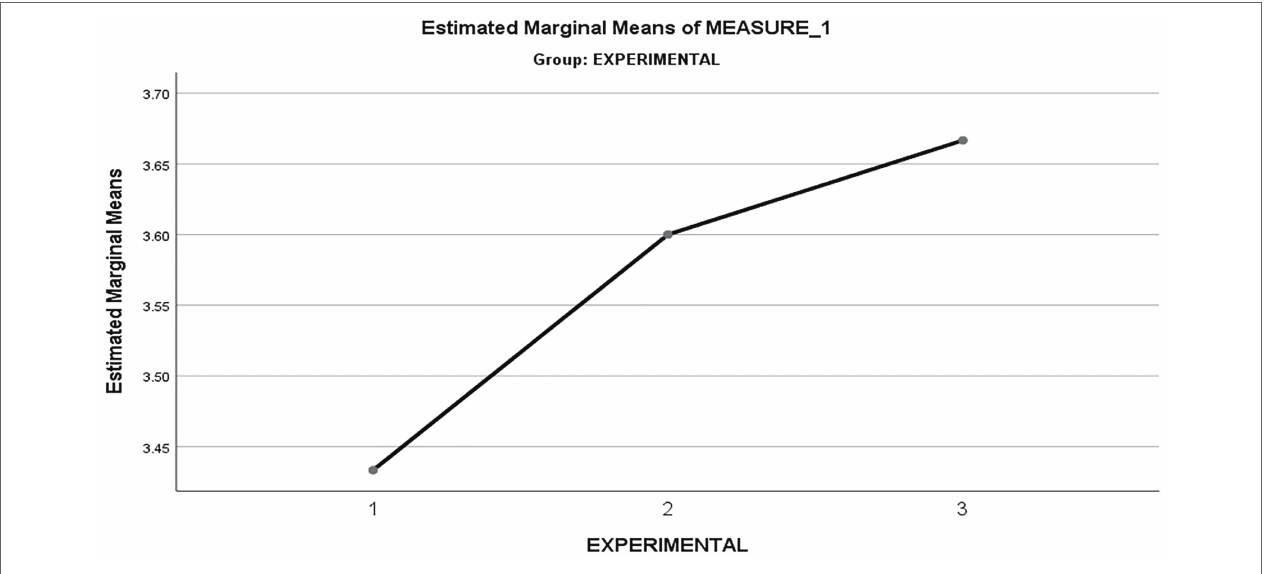
FIGURE 1 | Intervention Group Self-efficacy over Time 1, 2, and 3.